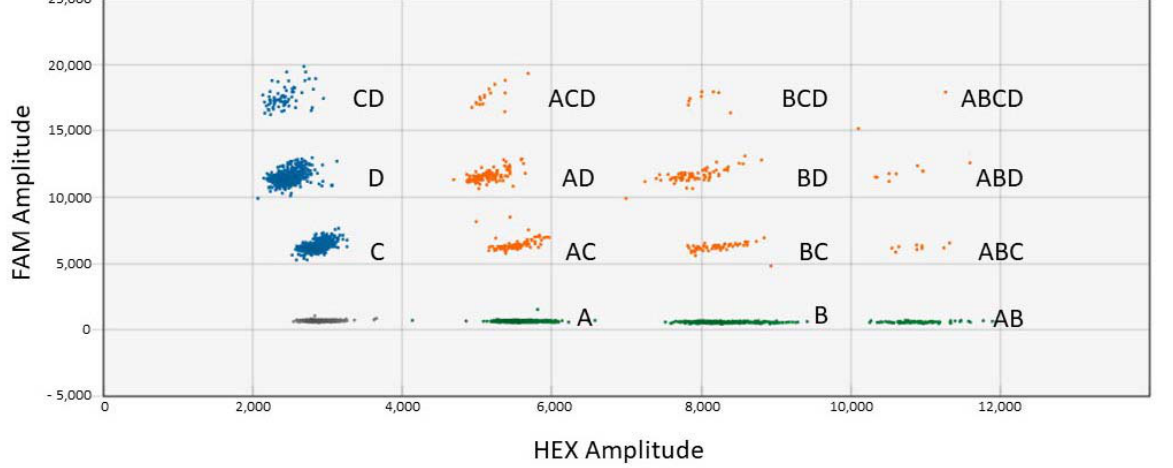
Figure 4. Droplet clusters generated for the soybean tetraplex ddPCR assay (two ‐ dimensional view). A = DP305423 event (HEX); B = DAS81419 event (HEX); C = MON89788 event (FAM); and D = A2704 event (FAM). The dark cluster represents negative droplets.